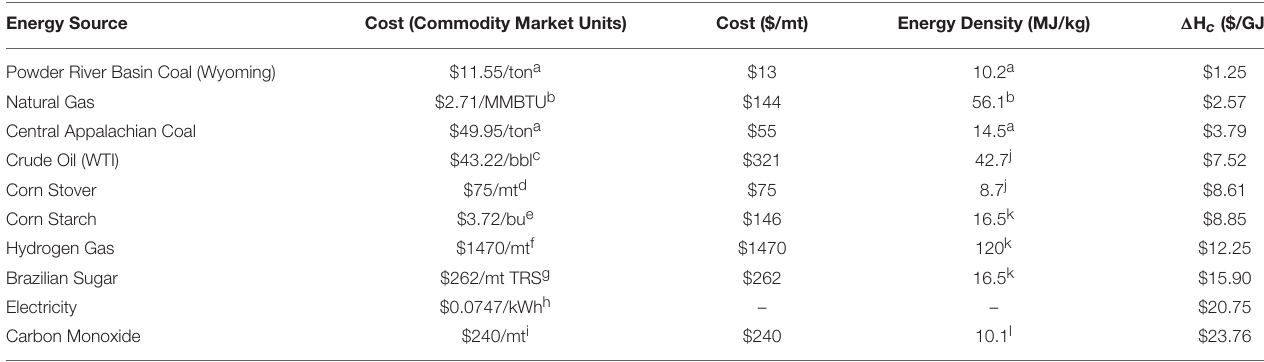
TABLE 3 | Commodity prices of fuel feedstocks, including common biomass, and fossil-derived sources. Energy